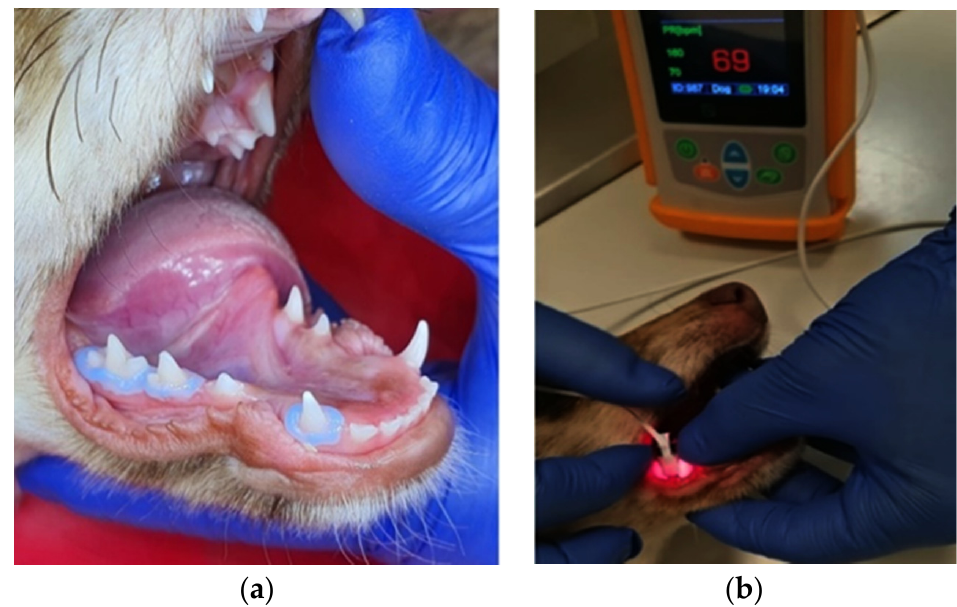
Figure 1. SpO 2 recording in a canine subject: ( a ) liquid rubber dam isolation of teeth 804, 806 and 807 before SpO 2 recording; ( b ) SpO 2 recording in tooth 807 in low light conditions.